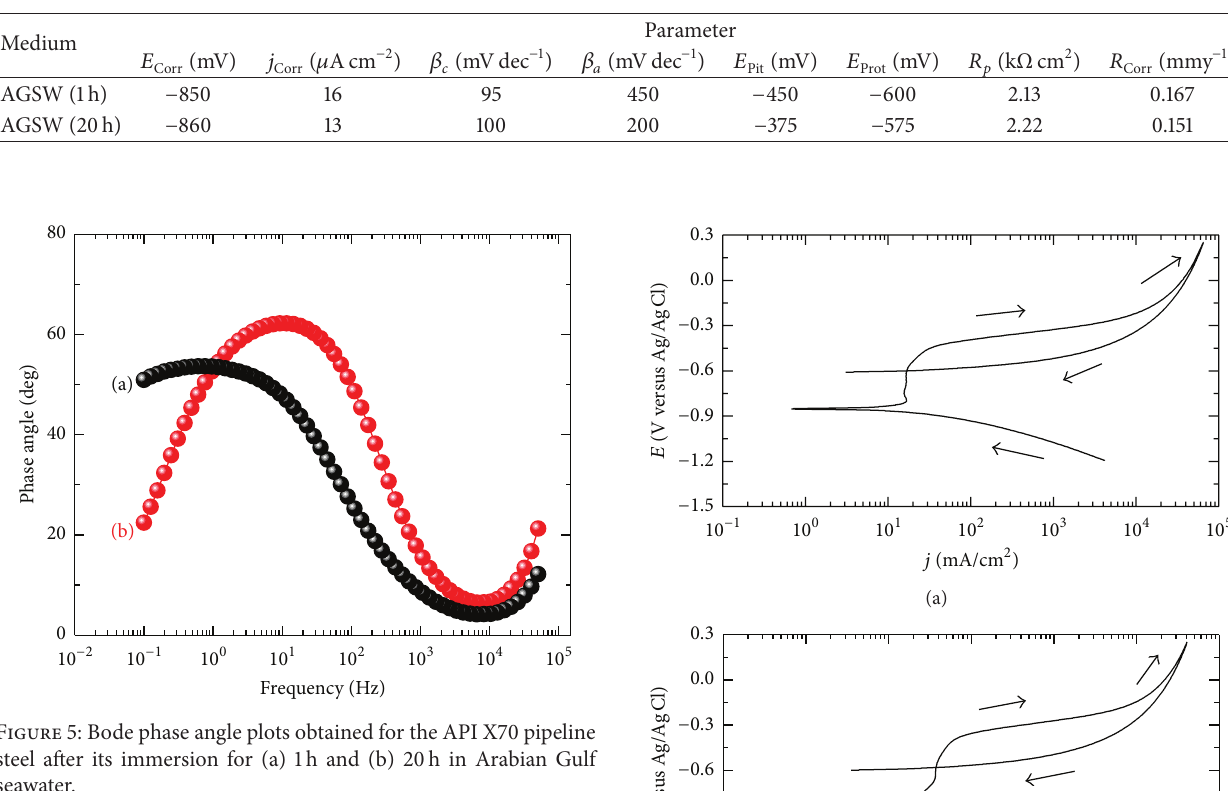
Table 2: Parameters obtained from cyclic potentiodynamic polarization curves shown in Figure 6 for X70 steel after 1h and 20 h immersion in Arabian Gulf seawater.